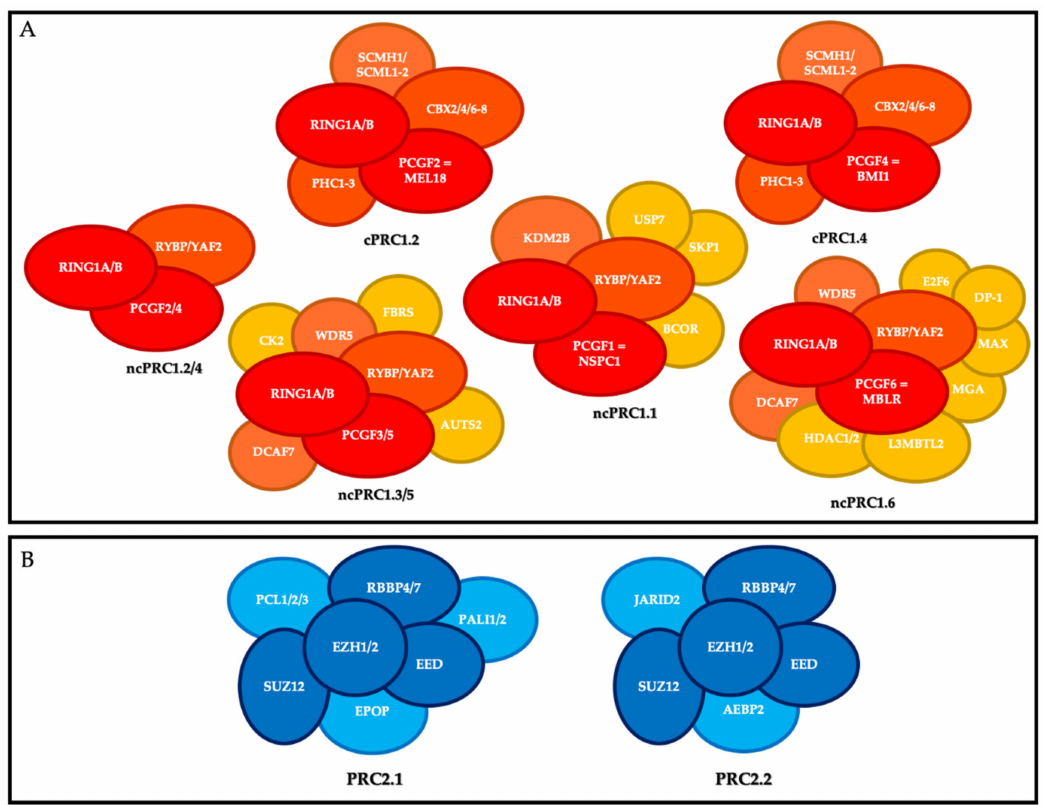
Figure 1. Polycomb repressive complexes (PRC). ( A ) Composition of canonical PRC1 (cPRC1) and non-canonical PRC1 (ncPRC1). Red, core members; orange, members that define the di ff erent canonical and non-canonical complexes; yellow, accessory factors. ( B ) Composition of PRC2. Dark blue, core members; light blue, members that define the di ff erent